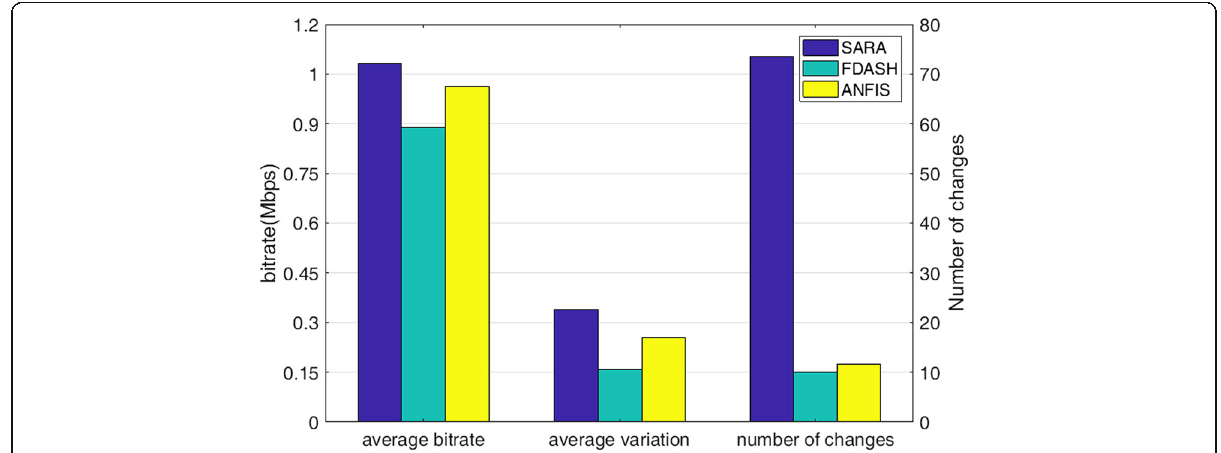
Fig. 13 Performance of each element of QoE in the second LTE